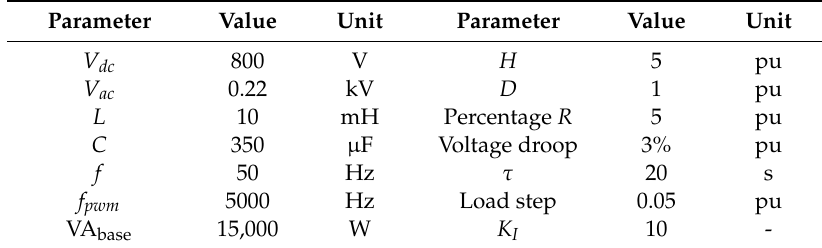
Table 2. Parameters in